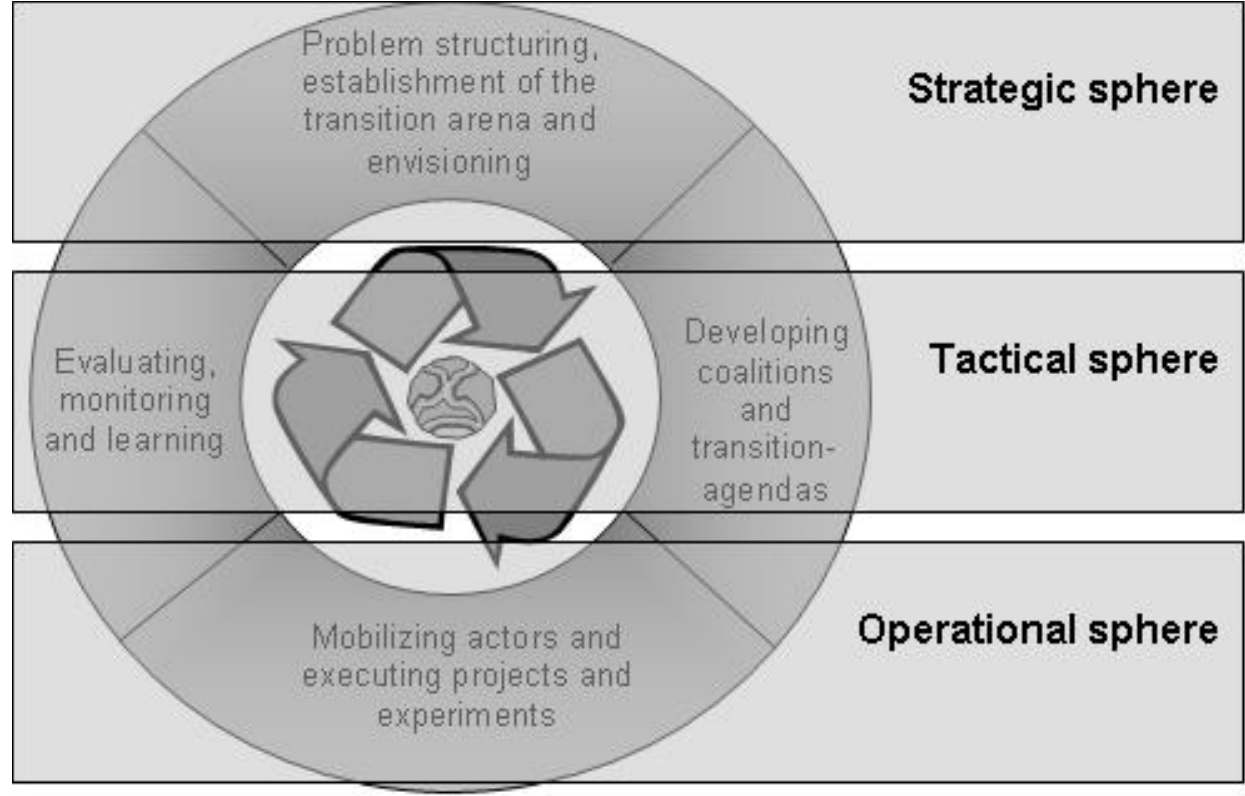
Fig. 2. Transition management is a cyclical, coordinated, multi-actor process at strategic, tactical, and operational levels and is organized around four co-evolving activity clusters (1) the establishment and development of a transition arena, (2) the creation of long-term integrated visions, transition pathways, and agendas, (3) the mobilization of actors and knowledge development through experimentation, and (4) the monitoring and evaluation of the transition process (Loorbach and Rotmans